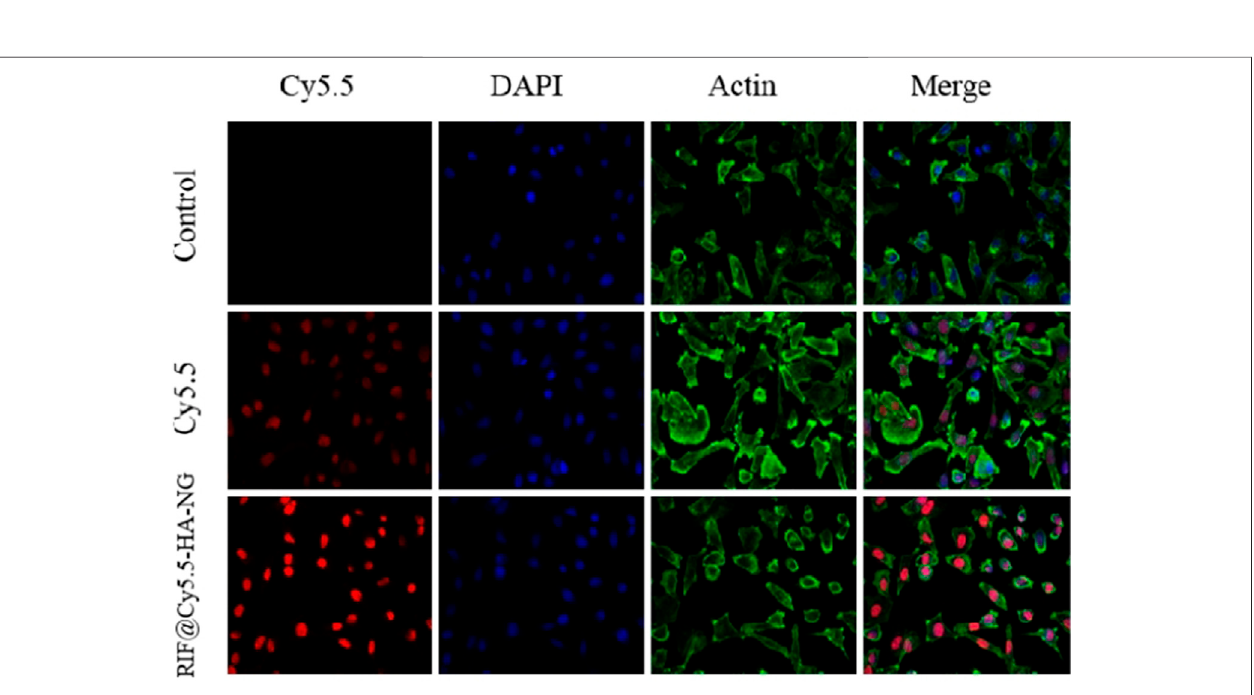
Frontiers in Molecular Biosciences |